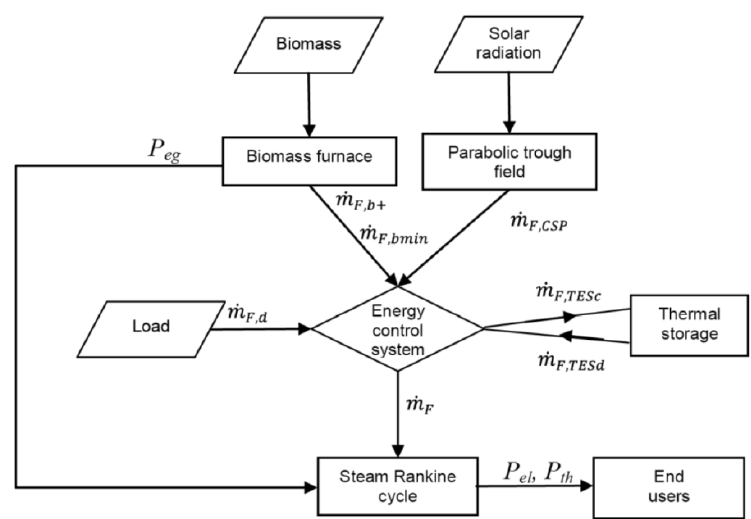
Figure 4. Energy conversion system flow